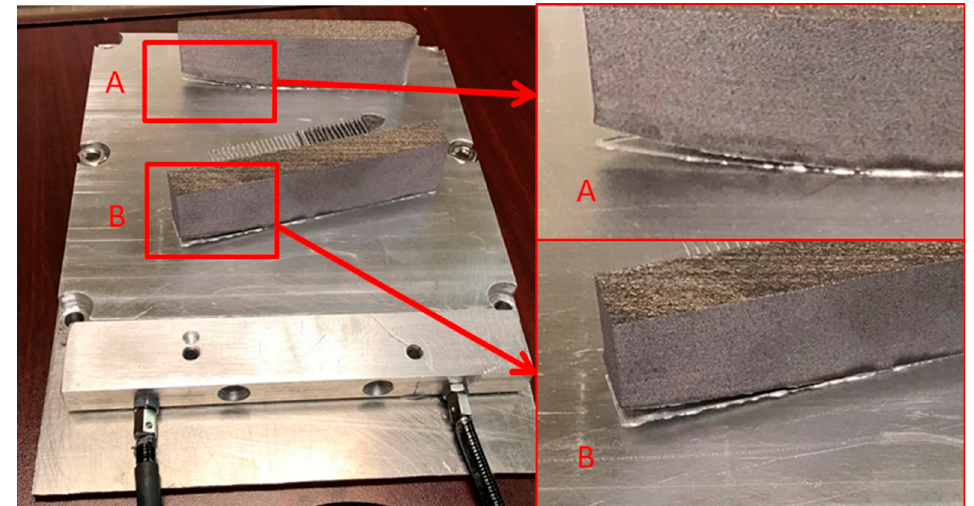
Figure 1. Delamination event from laser-powder bed fusion (L-PBF) evaluation in study. The components here were designed to intentionally delaminate. Delamination like this can occur on parts of interest, which often compromises the part.